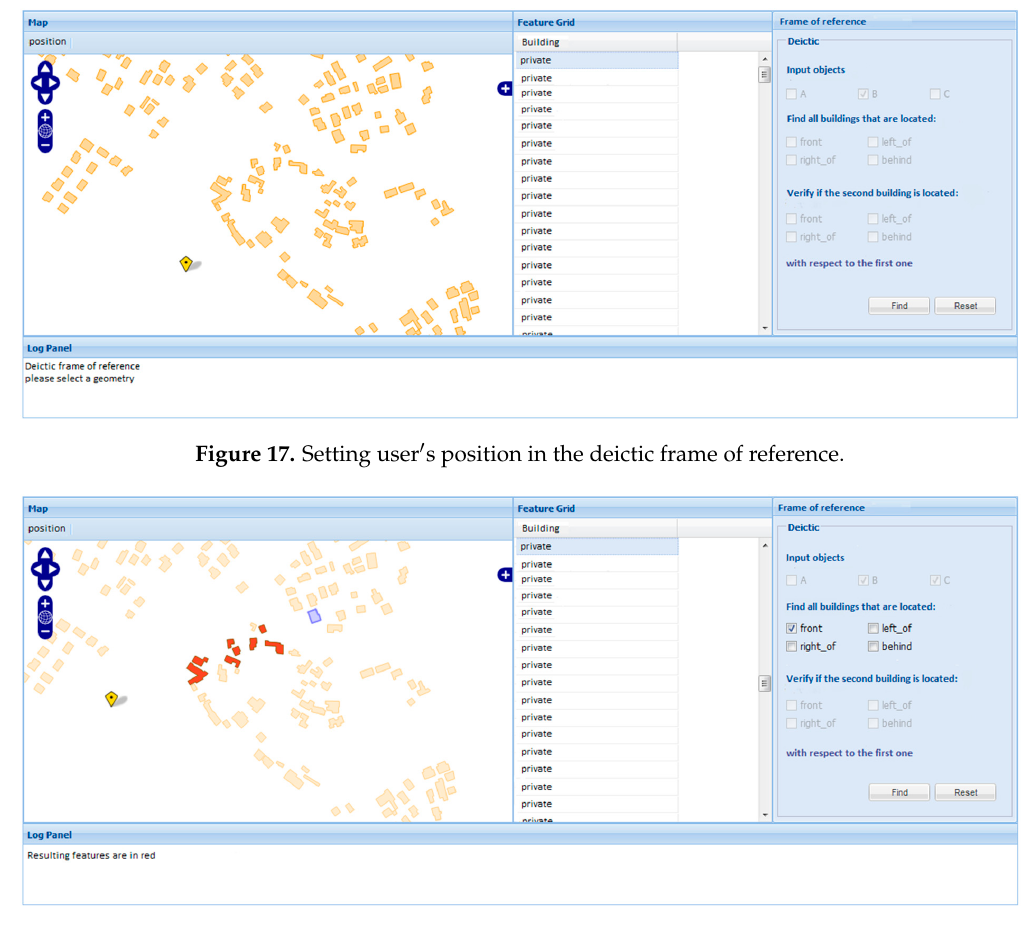
Figure 18. Houses in front of the selected building from the observer’s point of view.